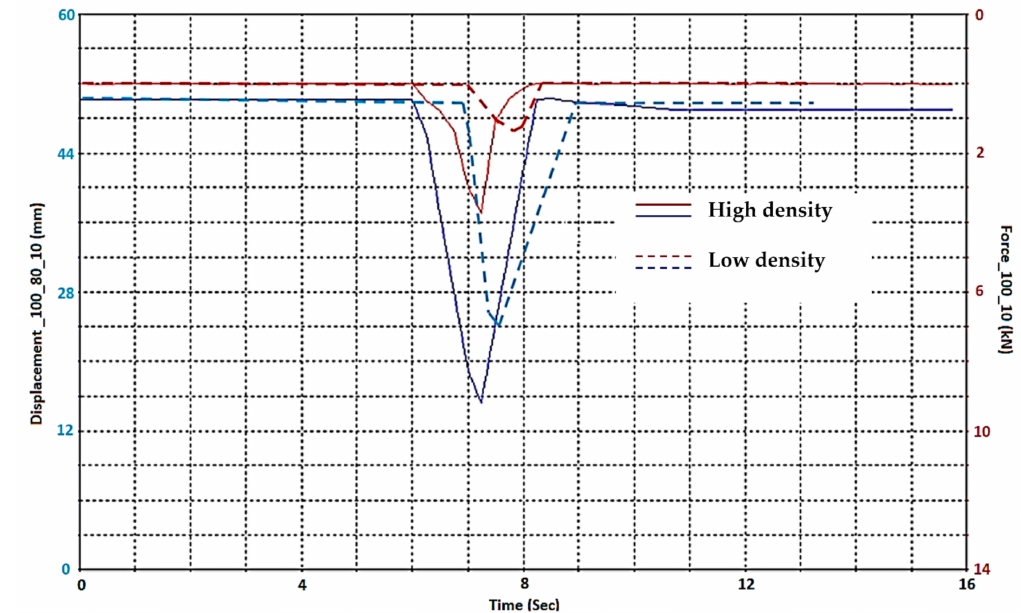
Figure 6. Actuator position vs. time for different sample densities, low (20 g/dm 3 ) and high (200 g/dm 3 ) density EPP foams.